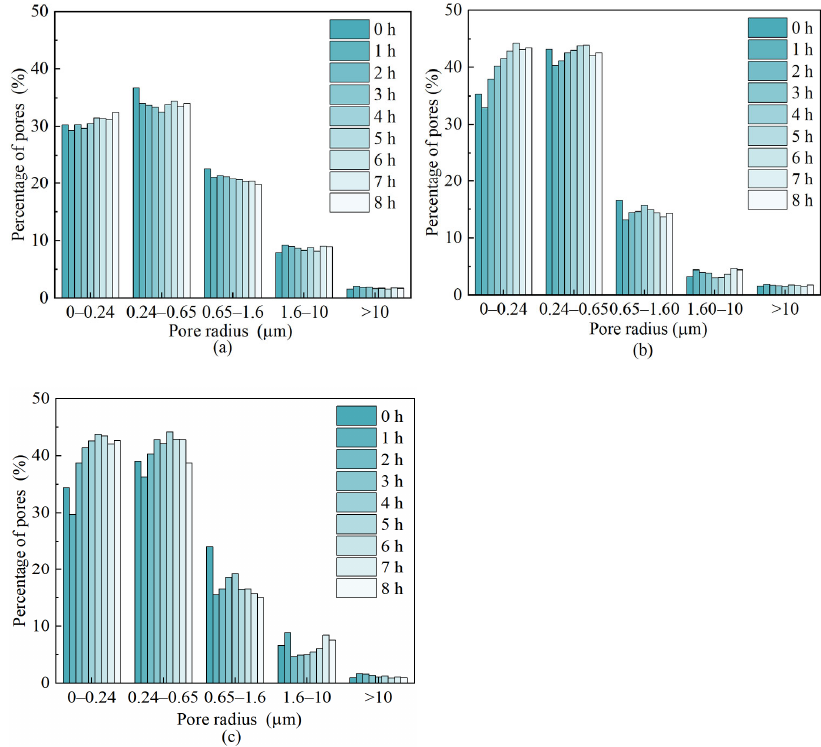
Figure 9. Variation of pore percentage of specimens in different concentrations of MgSO 4 and DI water leaching solution with leaching time. ( a ) DI water; ( b ) 2% MgSO 4 ; ( c ) 5% MgSO 4